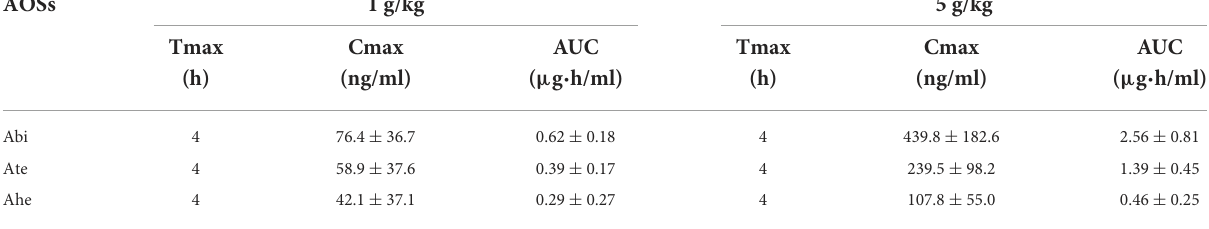
TABLE 1 Pharmacokinetic parameters of orally-administered AOSs in rat plasma.